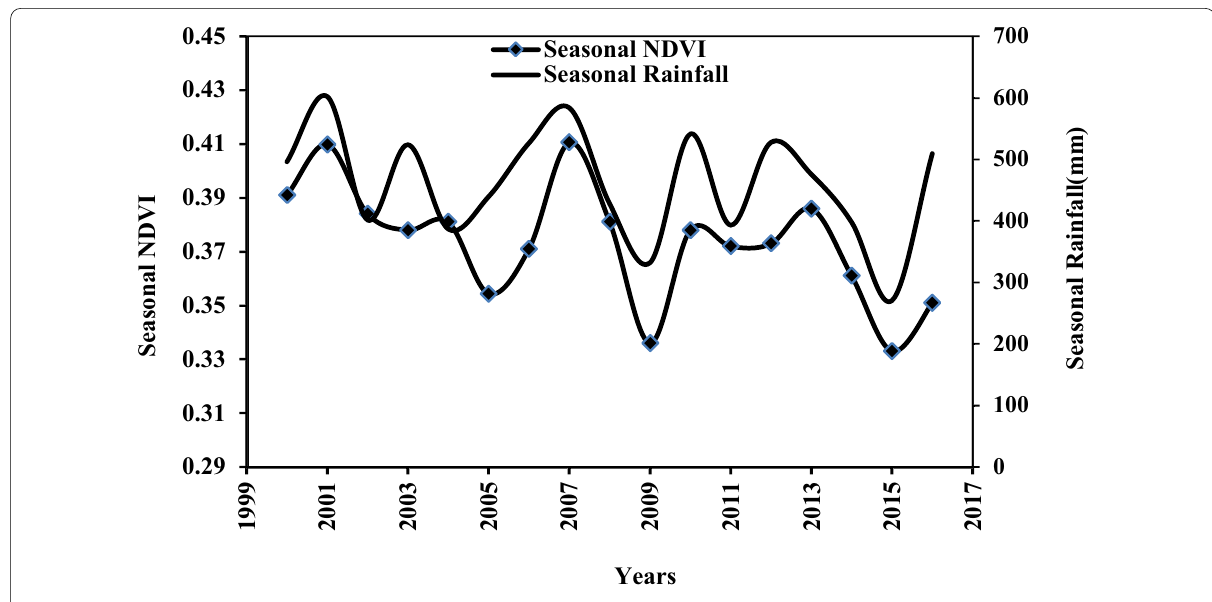
Fig. 5 Temporal trend of seasonal Rainfall and NDVI (2000 to